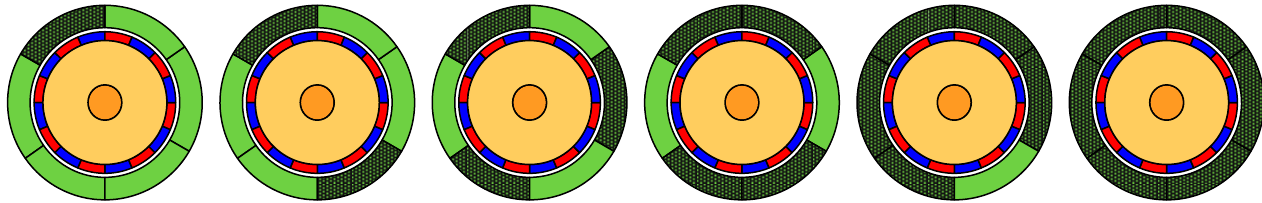
Figure 4. Possible configurations of segmented arc-shaped stator elements, at total number of segments, equal to 6.